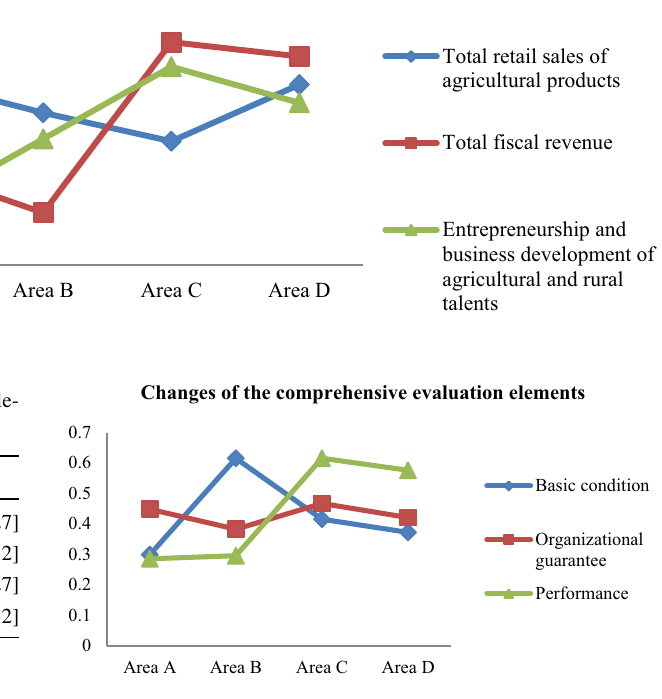
Table 7 Evaluation values of indicators 𝜗 2 =